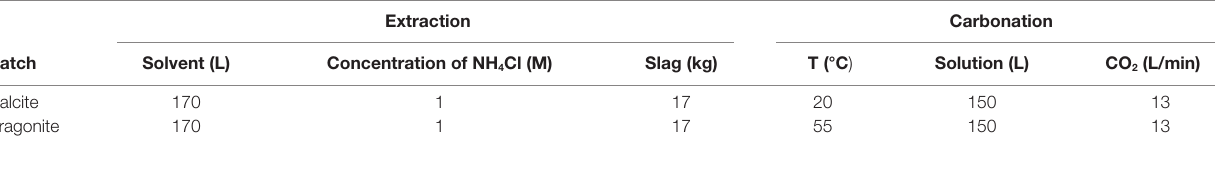
TaBle 3 | summary of calcium carbonate batch production